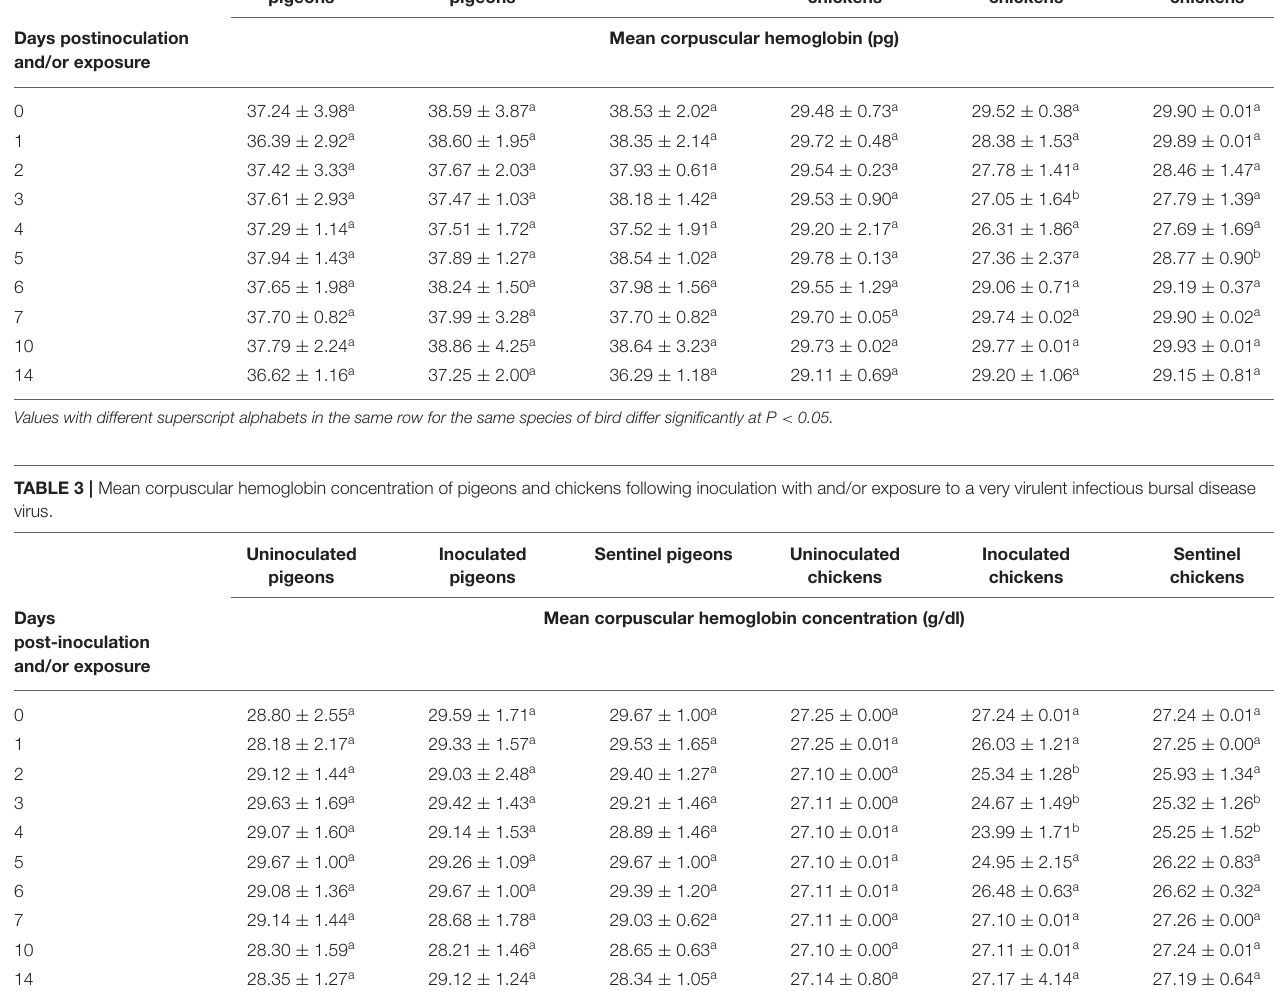
Uninoculated Inoculated Sentinel pigeons Uninoculated pigeons pigeons